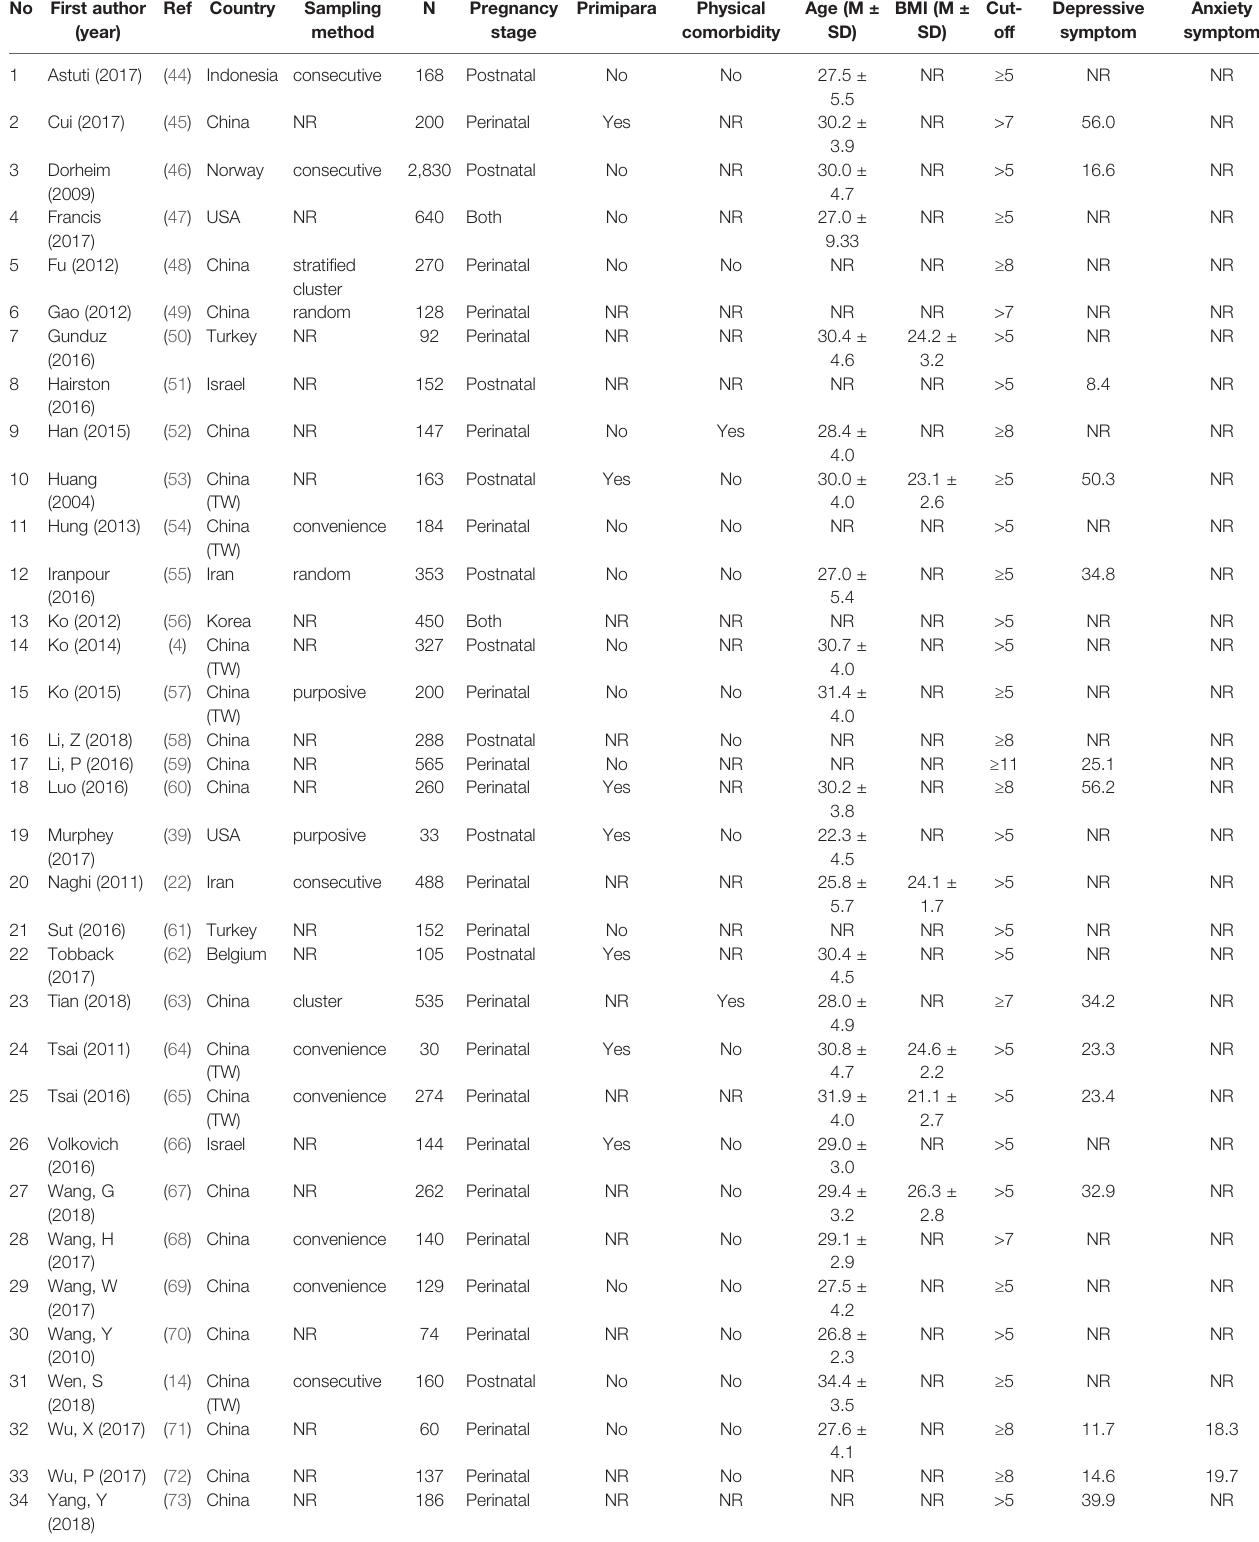
TABLE 1 | Characteristics of the included